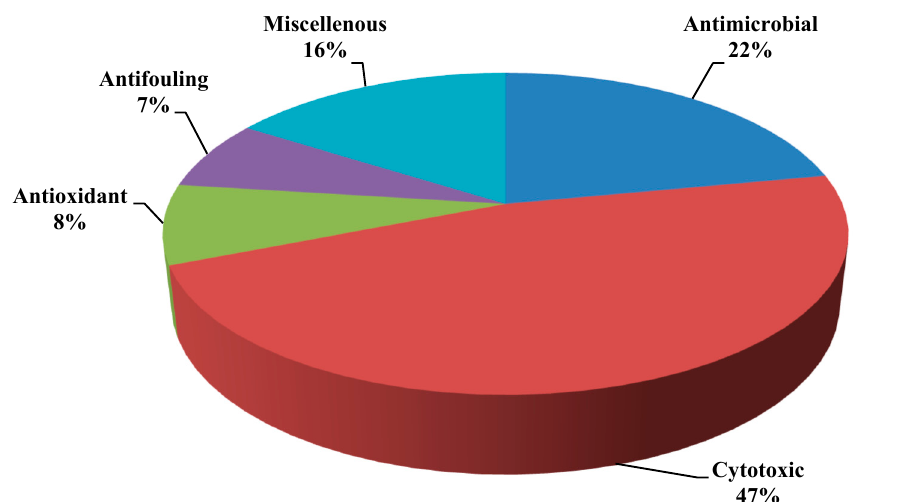
Figure 10. Percentages of different biological activities for the bioactive alkaloids of genus Aspergillus. Table 1. Diverse alkaloids isolated from marine derived fungal strains and their biological activities.